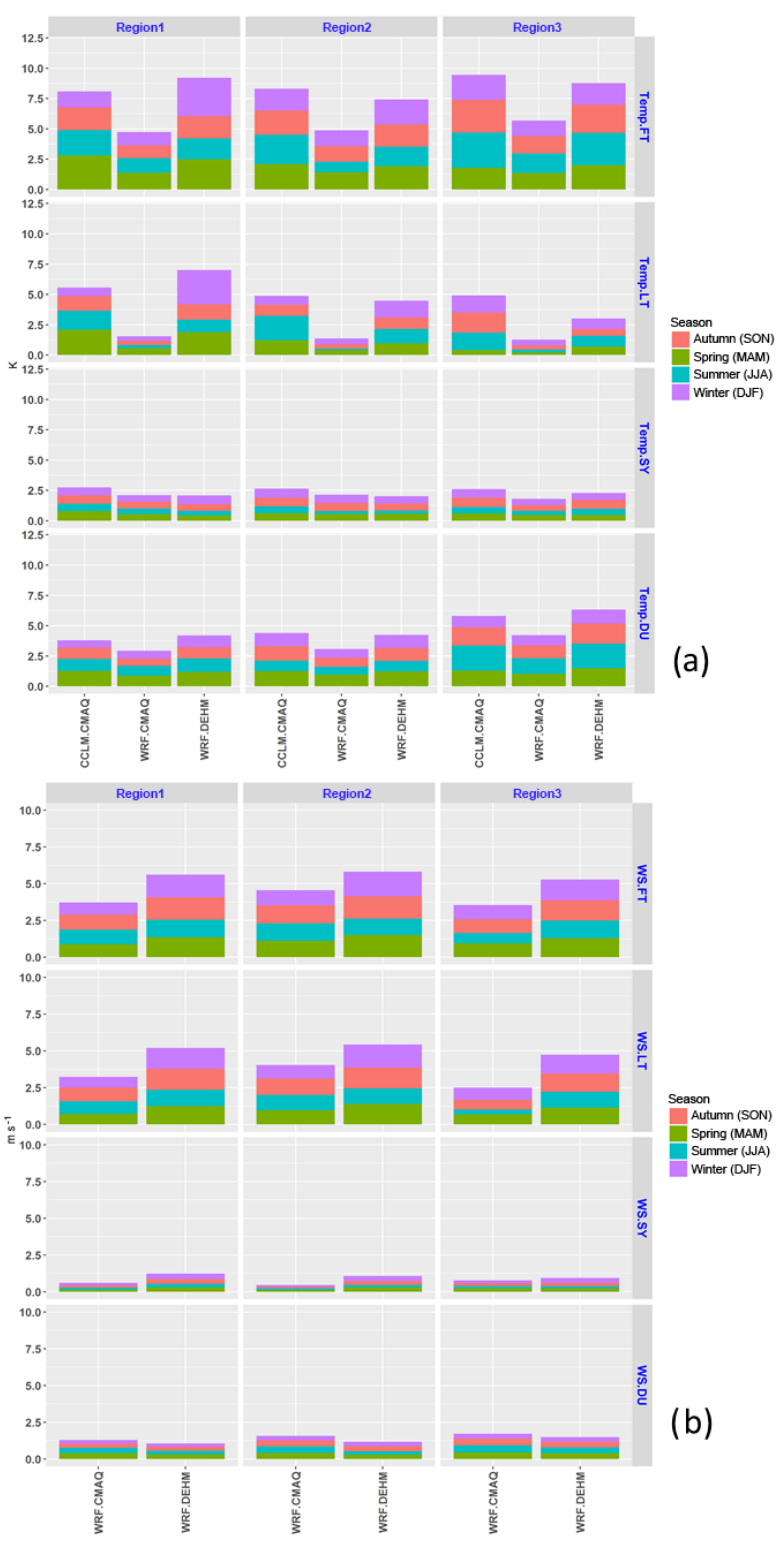
Figure 3. RMSE for (a) temperature and (b) WS in North